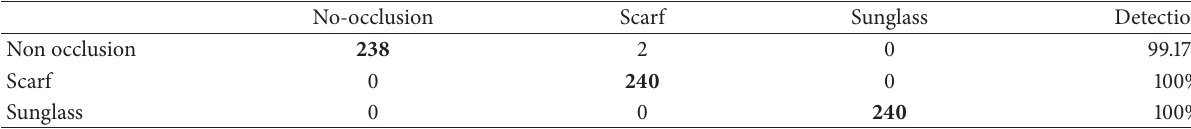
Table 2: Results of occlusion detection.